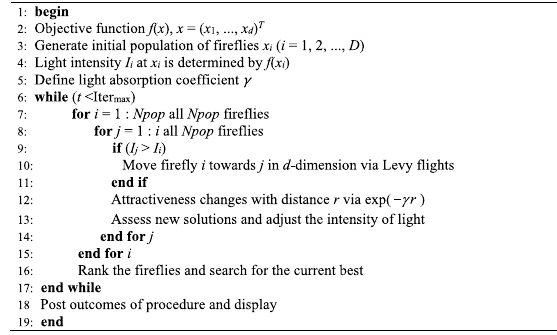
Algorithm 1. LFA (Yang,